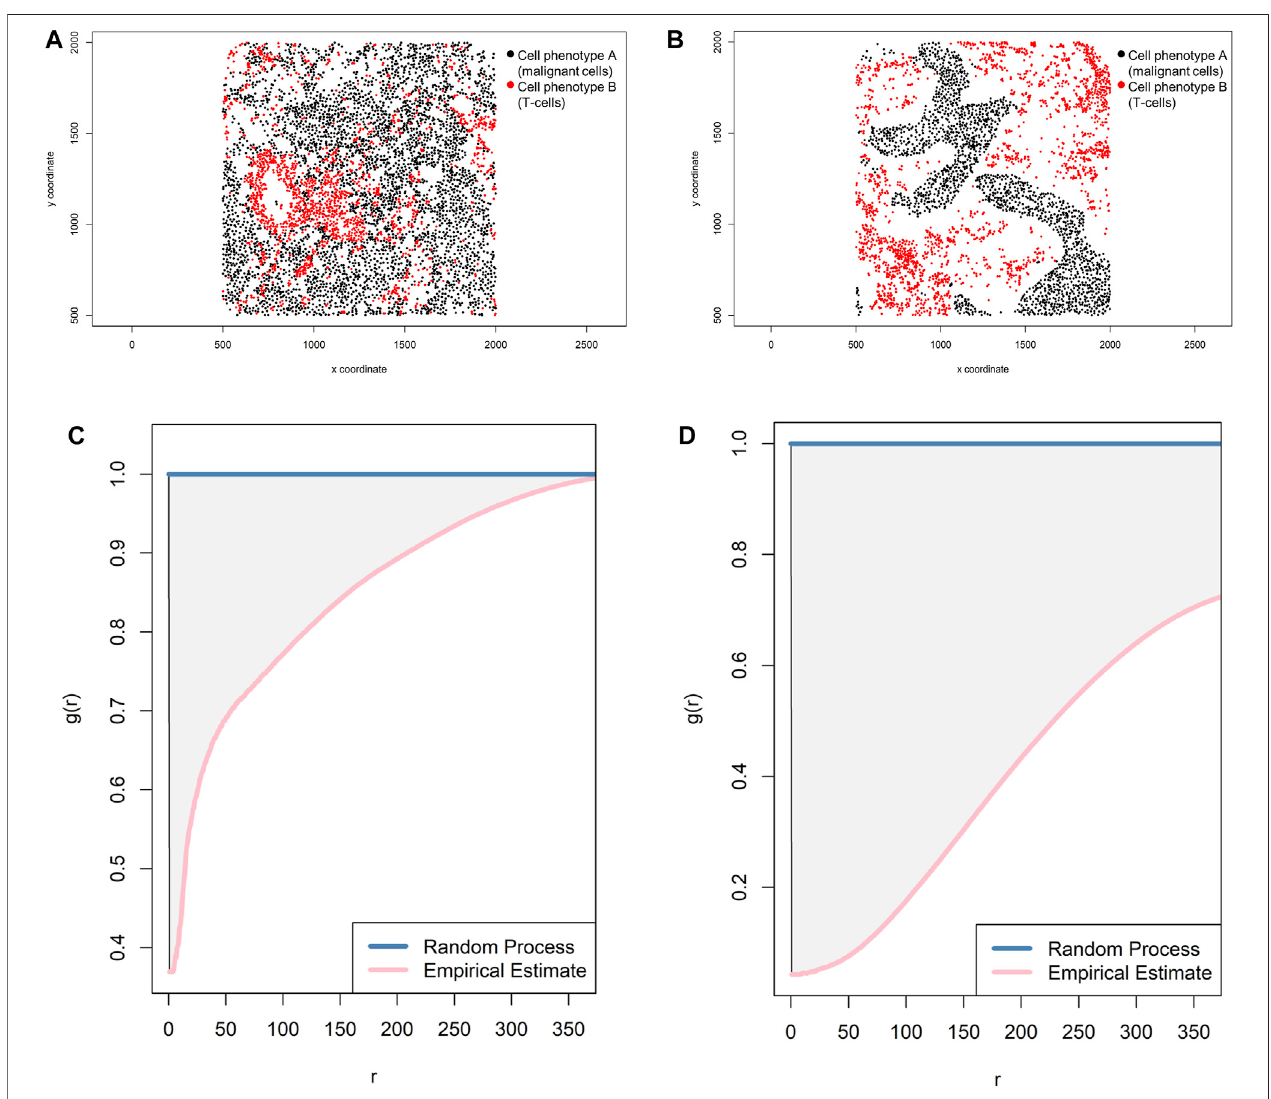
FIGURE 13 | Representative graphs showing the pair correlation function [g( r )] for two different cellular distribution patterns between two group of cells from a representative point pattern in multiplex immuno fl uorescence images of lung adenocarcinoma. (A) Random point pattern distribution of cell phenotype A and B. (C) Graphic representation of the g( r ) curve showing a line forming downward from the theoretical estimate (Poisson line), characterizing a random or mixed pattern of one cell phenotype in relation to another cell phenotype. (B) Unmixed point pattern distribution of cell phenotype A and B. (D) Graphic representation of the g( r ) curve showing increased distance below the theoretical estimate (Poisson line), characterizing a clustering or unmixed pattern of one cell phenotype in relation to another cell phenotype. The graphics were generated using R studio software version 3.6.1.